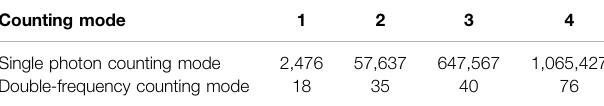
TABLE 1 | Counted photon number of ambient light under two counting